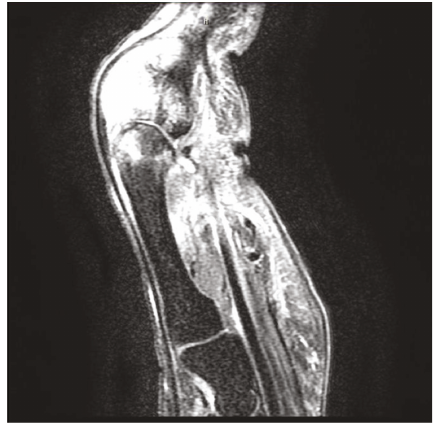
Figure 3: T2 sagittal MRI image of the described